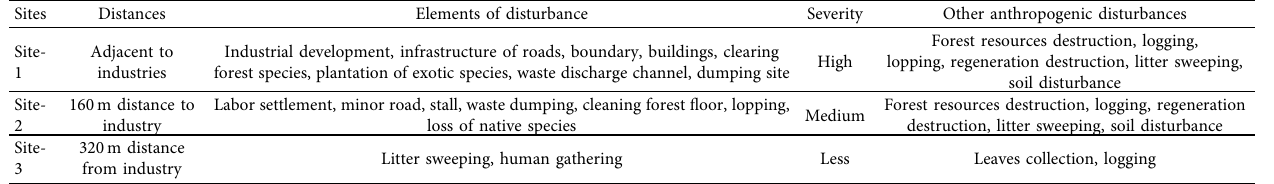
Table 1: Disturbance status of three distance sites in the study area.